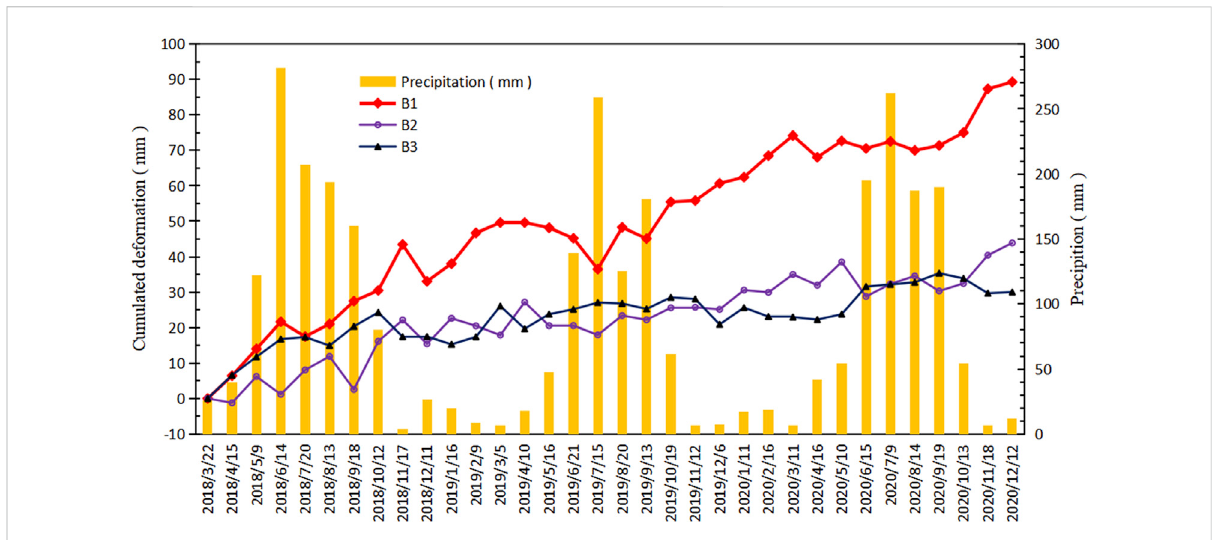
FIGURE 12 Time series deformation of feature points and precipitation in the rear